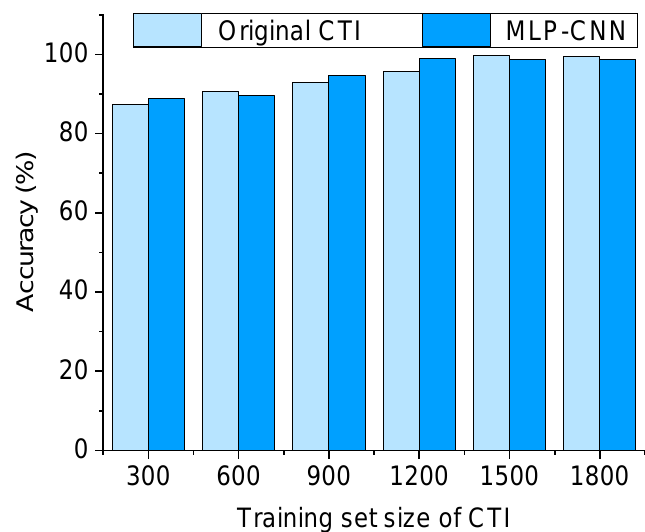
Figure 20. Accuracy of the original CTI and the MLP–CNN subject to di ff erent numbers of crack ROIs in the training set.